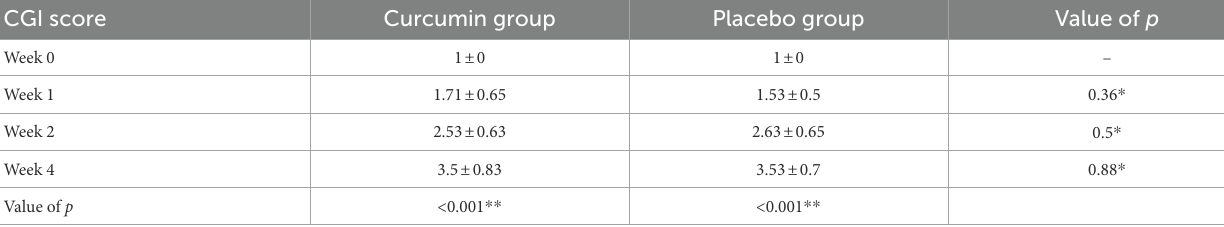
TABLE 4 Changes in the CGI score of the two groups in the study. CGI